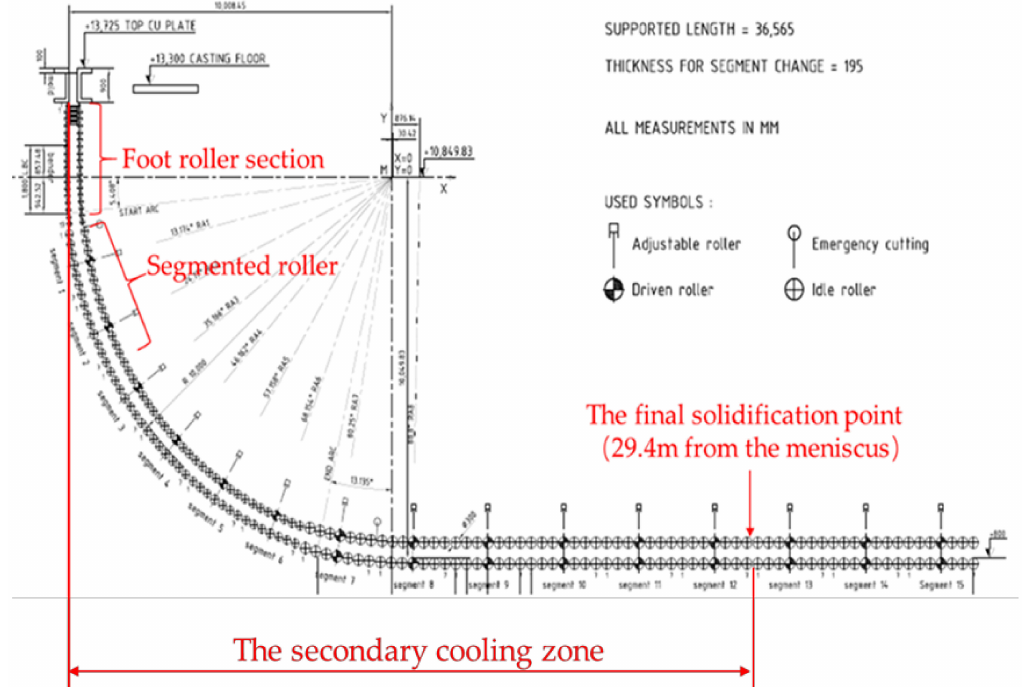
Figure 1. Slab caster roller